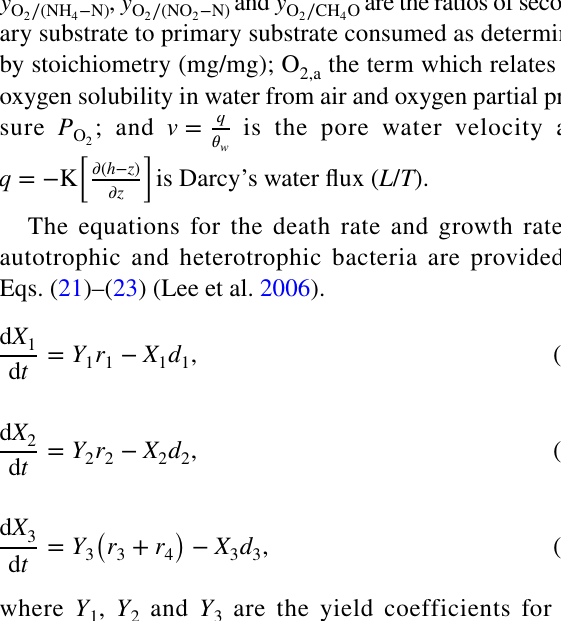
Table 1 Expressions for sorption isotherms and corresponding retardation factors (Vasudevan et al. 2015)